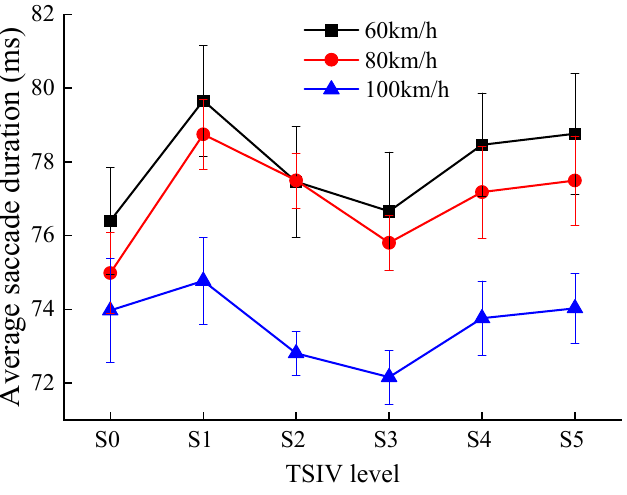
Figure 9. The comparison of average saccade duration for each TSIV at the three speeds.